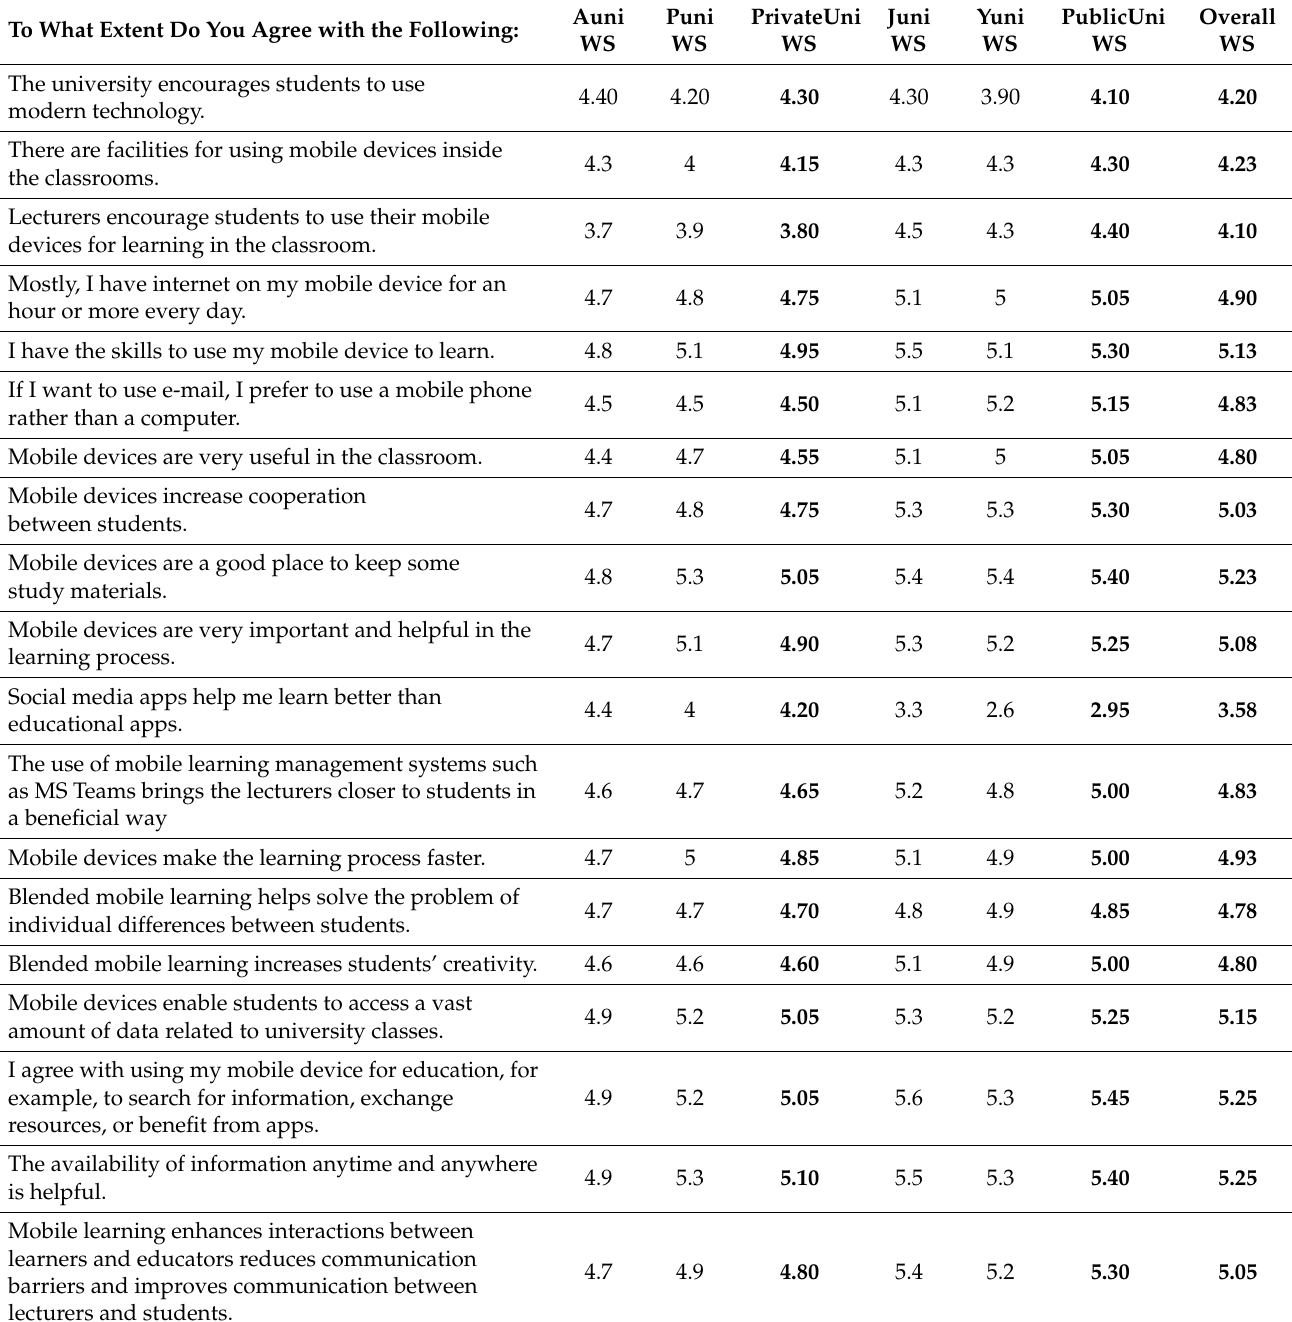
Table 7. Current state of